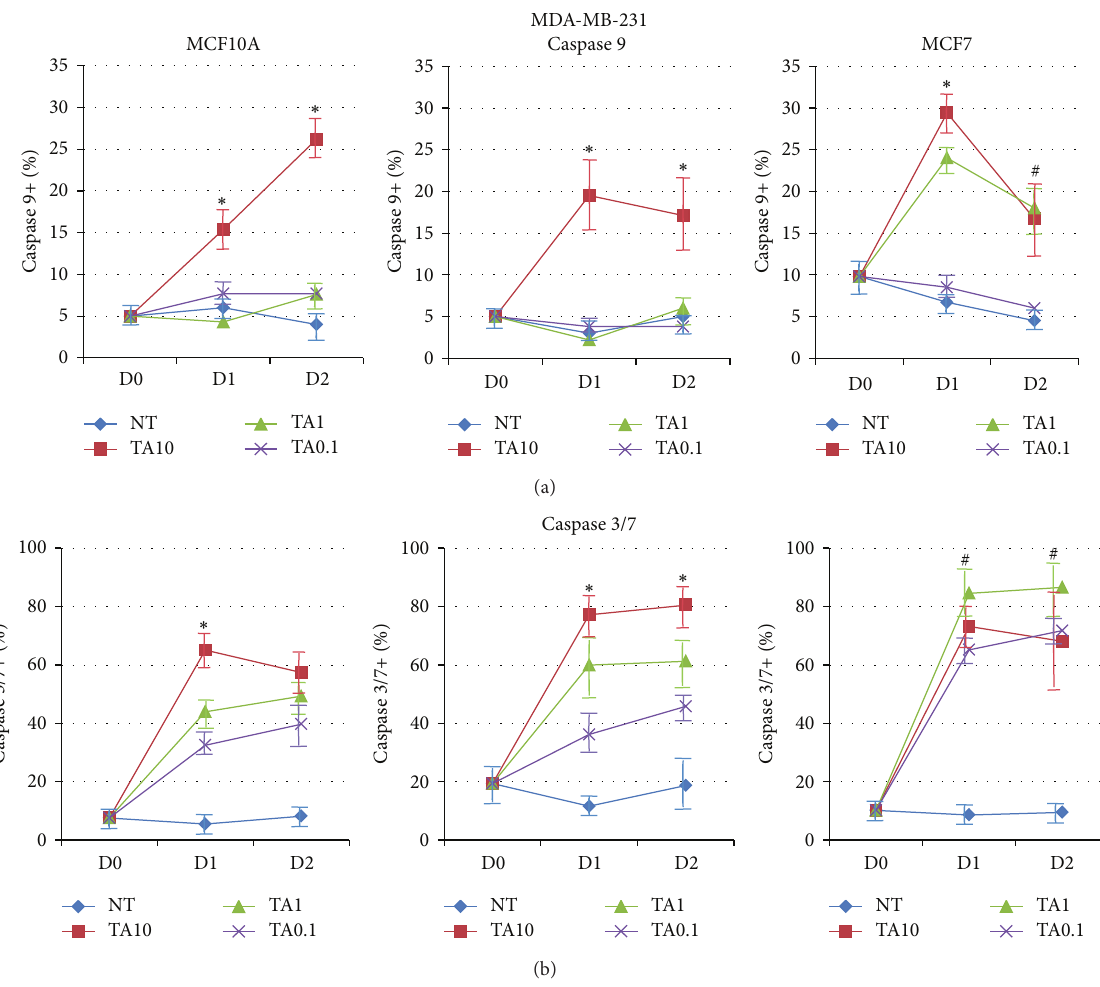
Figure 5: Tannic acid exposure induces apoptosis in breast cells via induction of caspases. MCF10A, MDA-MB-231, and MCF7 cells were untreated or treated with 10%, 1.0%, and 0.1% TA cross-linked beads for 24 and 48 h. Levels of activated (a) caspase 9 and (b) caspase 3/7 were determined using flow cytometry. NT: no treatment. ∗ 𝑃 < 0.05 TA 10 versus other treatments, # 𝑃 < 0.05 MCF7 versus